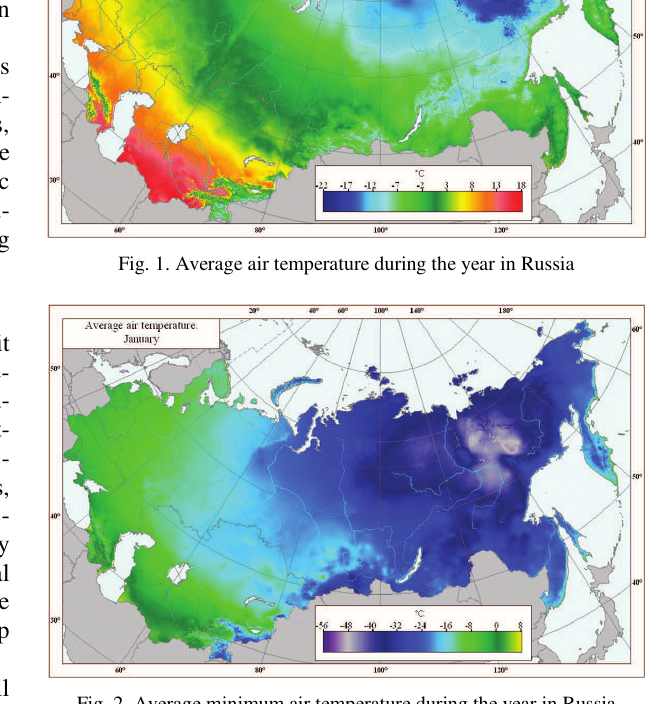
Fig. 2. Average minimum air temperature during the year in